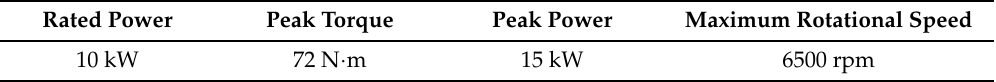
Table 4. ISG motor parameters of four-wheel drive HEV.